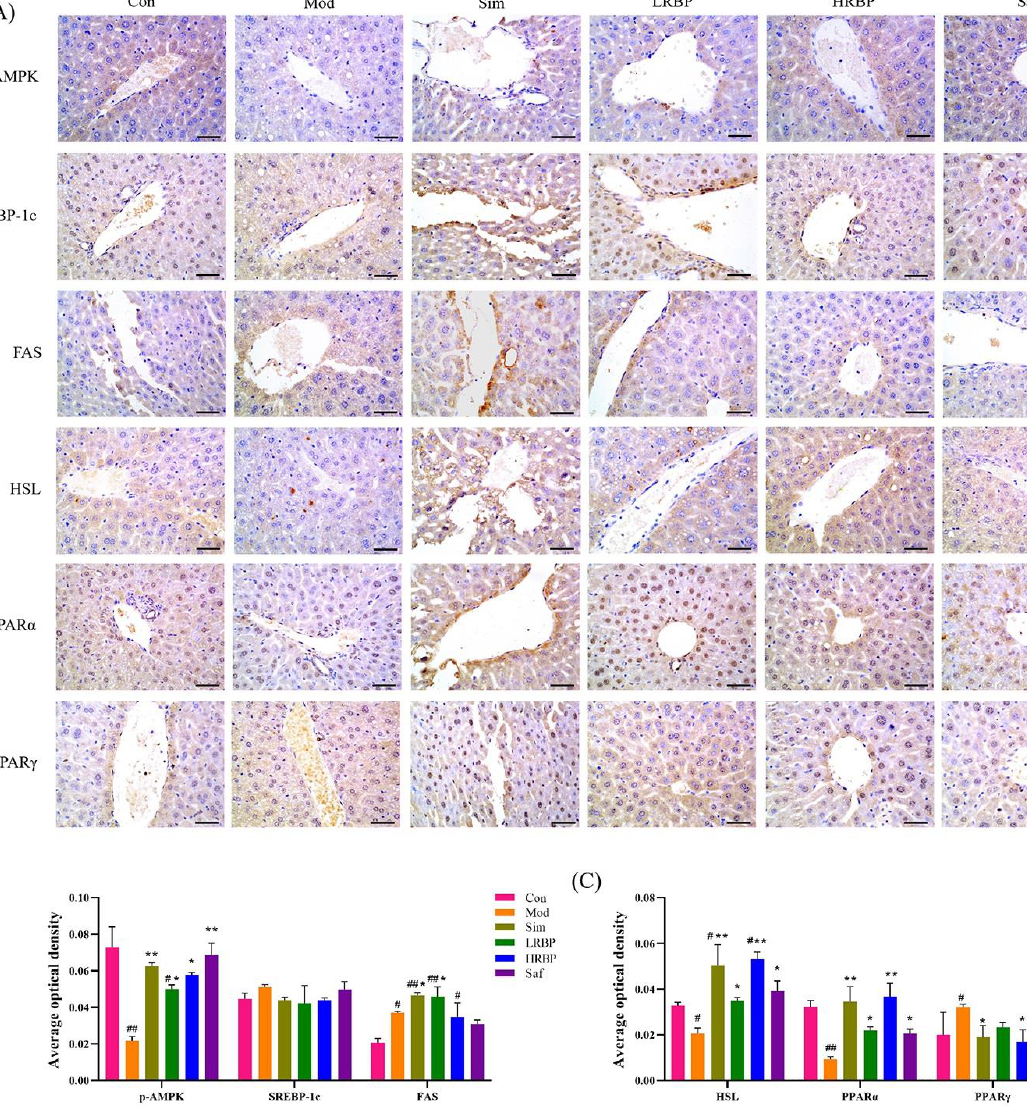
Figure 4. Effect of RBPs on the expression of lipid metabolism-related genes in the liver. ( A ) Immuno- histochemical results of mice liver (scale bar = 50 µ m). ( B , C ) Determination results of average optical density. The results were measured by Image-Pro Plus 6.0 software. # p < 0.05, ## p < 0.01 compared to Con group, * p < 0.05, ** p < 0.01 compared to Mod group. Con, control group fed with normal diet; Mod, model group fed with HFD; Sim, positive control group fed with HFD and treated with simvastatin; LRBP, low dose RBPs group fed with HFD and treated with 200 mg/kg RBPs; HRBP, high dose RBPs group fed with HFD and treated with 600 mg/kg RBPs; Saf, safety evaluation group fed with normal diet and treated with 600 mg/kg